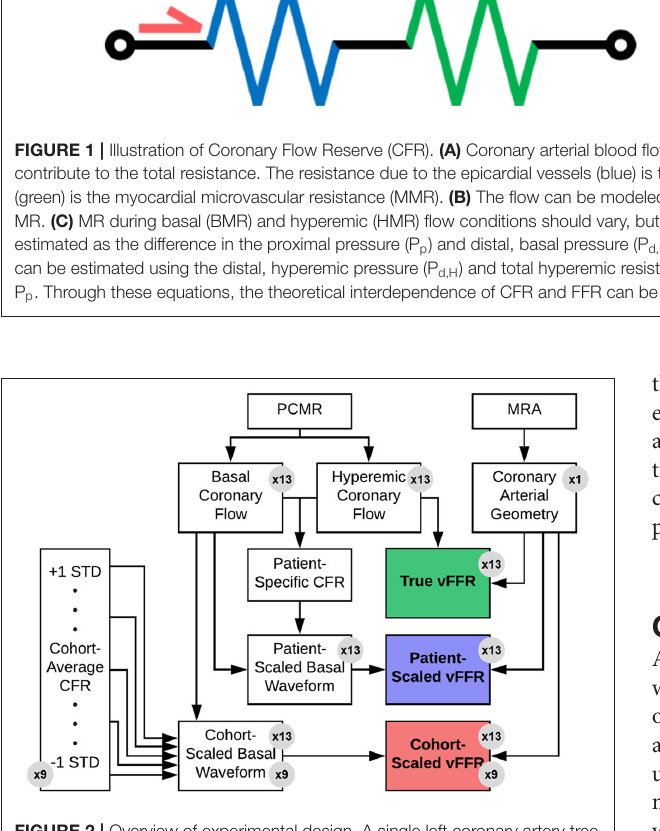
FIGURE 2 | Overview of experimental design. A single left coronary artery tree was acquired from an MRA of a patient with a 50% stenosis in the LAD. Hyperemic and basal flow waveforms were measured in patients ( n = 13) using PCMR. Each hyperemic flow waveform was applied as an inflow boundary conditions for the anatomic model to determine the true vFFR value via CFD. Each basal flow waveform was then scaled by either the patient-specific or one of nine estimated CFR value to approximate the hyperemic flow. These scaled flow rates were then applied as inflow boundary CFD simulations to estimate vFFR—i.e., patient-scaled vFFR or cohort-scaled vFFR. These scaled vFFR values were then compared to the corresponding true vFFR